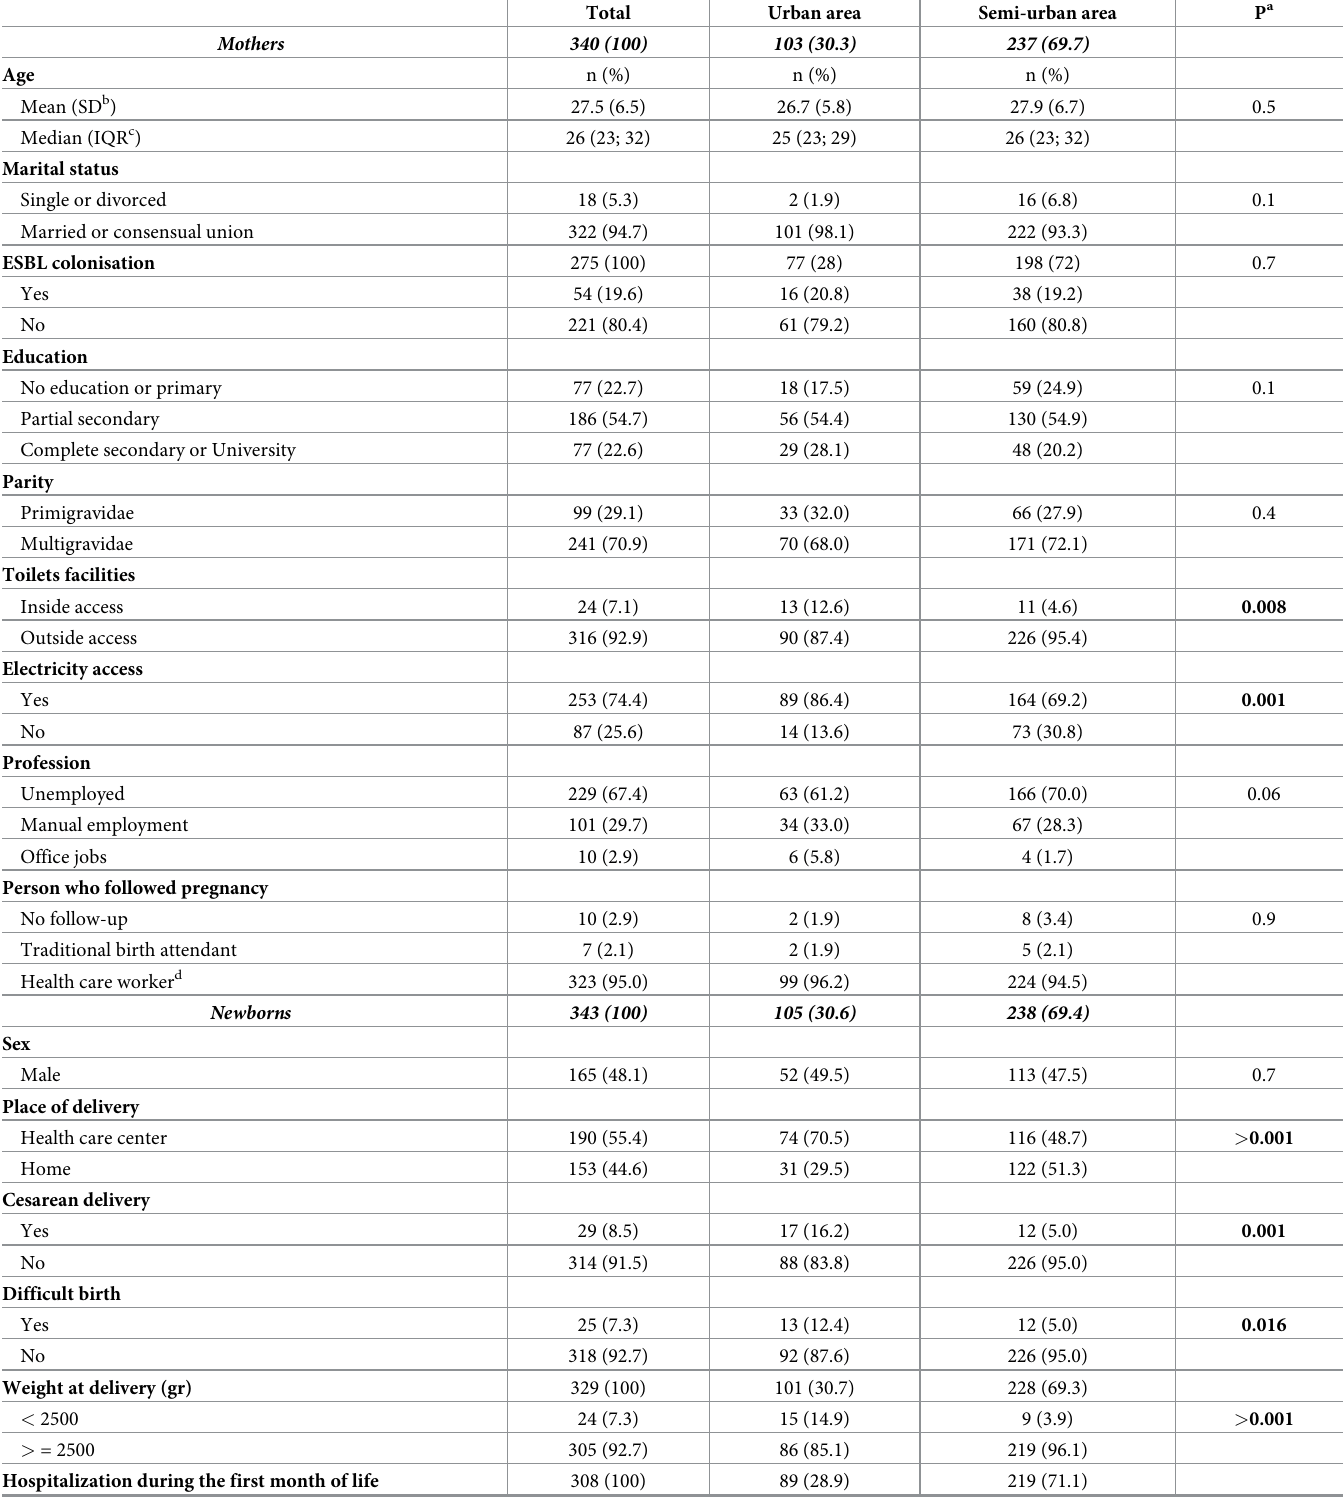
Table 1. Characteristics of the mothers and